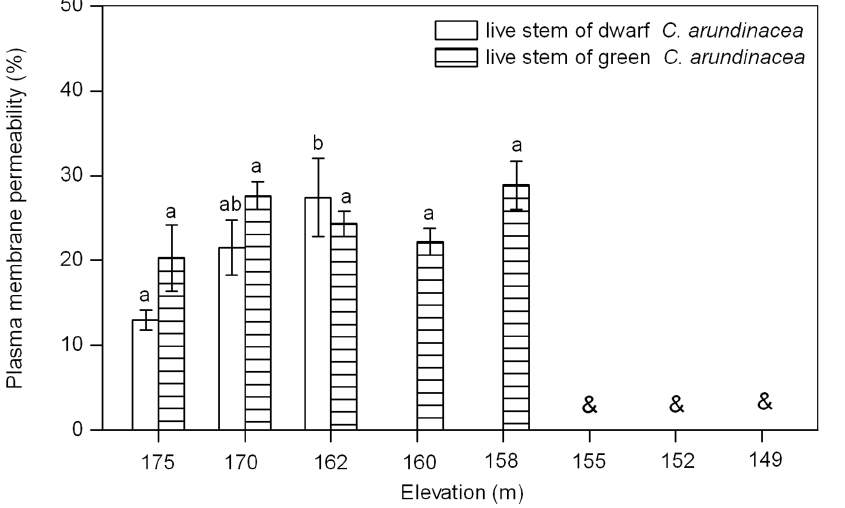
Figure 3. Effects of flooding on plasma membrane permeability of dwarf and green C.arundinacea . Values are mean 6 SE based on five independent assays. Different letters indicate statistical significance ( P , 0.05) according to Duncan’s test, while & indicate that no samples were available at the elevation.